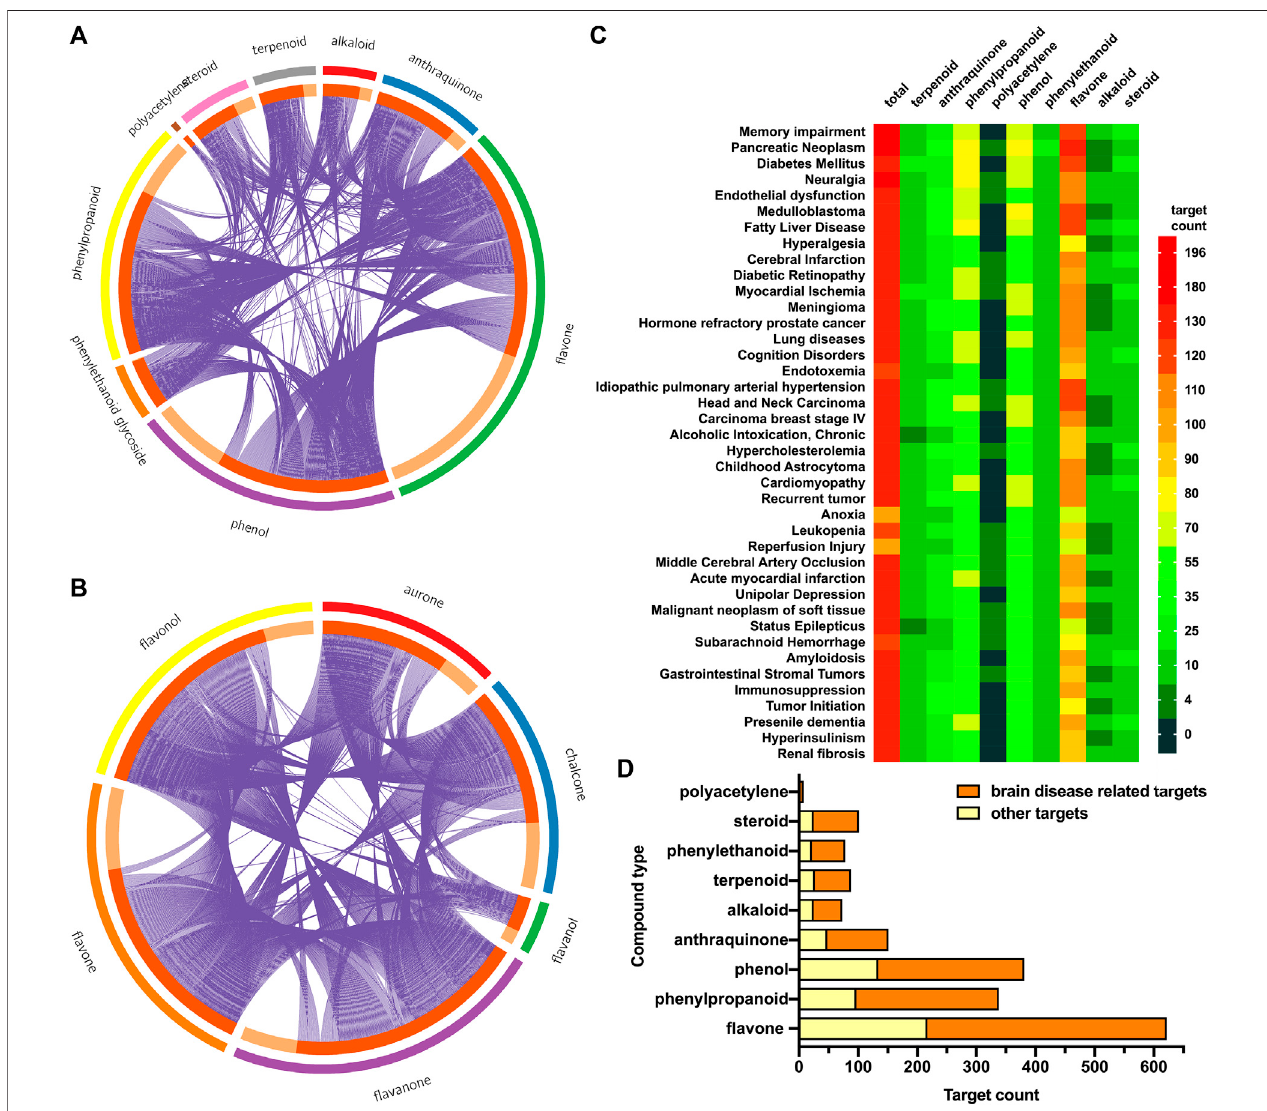
FIGURE 3 | Target prediction and enrichment analysis in DisGeNET for each kind of compounds. (A) The distribution and overlap of targets for all kinds of compounds.Outercircle:differentkindsofcompounds;innercircle:predictedtargetsforthiskindofcompounds;purpleline:thesametargetsharedbydifferentkindsof compounds. (B) The distribution and overlap of targets for different kinds of fl avones (chalcone, aurone, fl avanone, fl avone, fl avonol, and fl avanol). (C) Top 40 enriched diseasesinDisGeNETfordifferentkindsofcompounds.Colorbarrepresentedtargetgenecounts. (D) Totaltargetsforeachkindofcompounds,aswellastargets enriched in items of brain-related